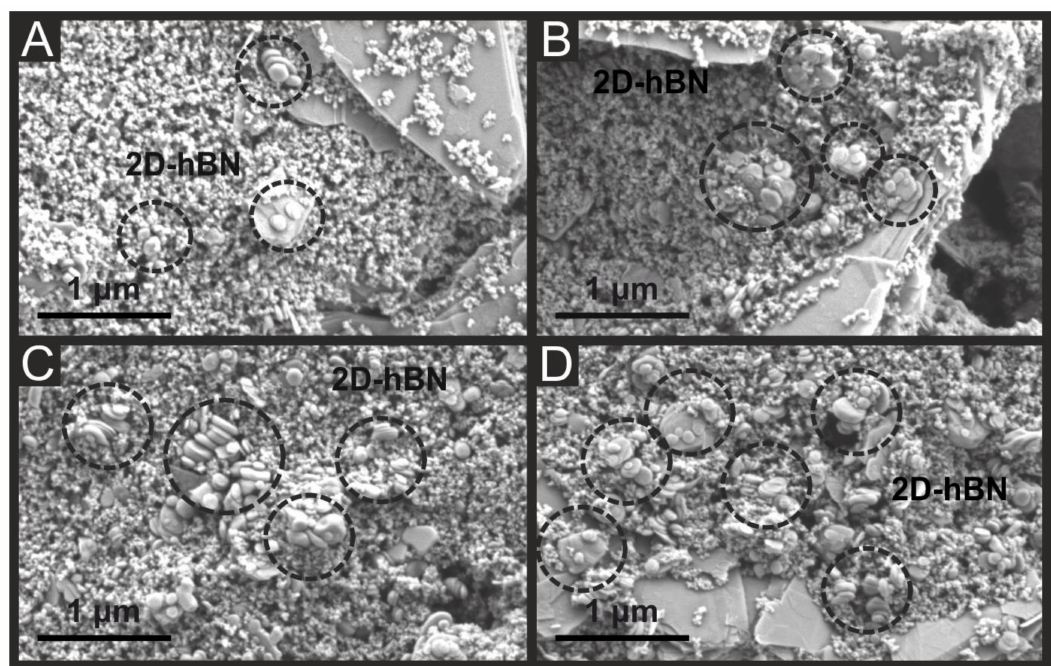
Figure 4. Typical scanning electron micrographs for SPE with 1% 2D-hBN ( A ), 5% 2D-hBN ( B ), 10% 2D-hBN ( C ) and 15% 2D-hBN ( D ). 2D-hBN platelets are evident as layered disk-like stacked vertical heterostructures of ca. 200 nm in